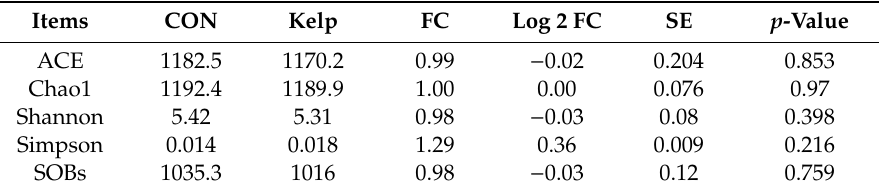
Table 3. E ff ects of kelp powder on α -abundance of ruminal microbiota.